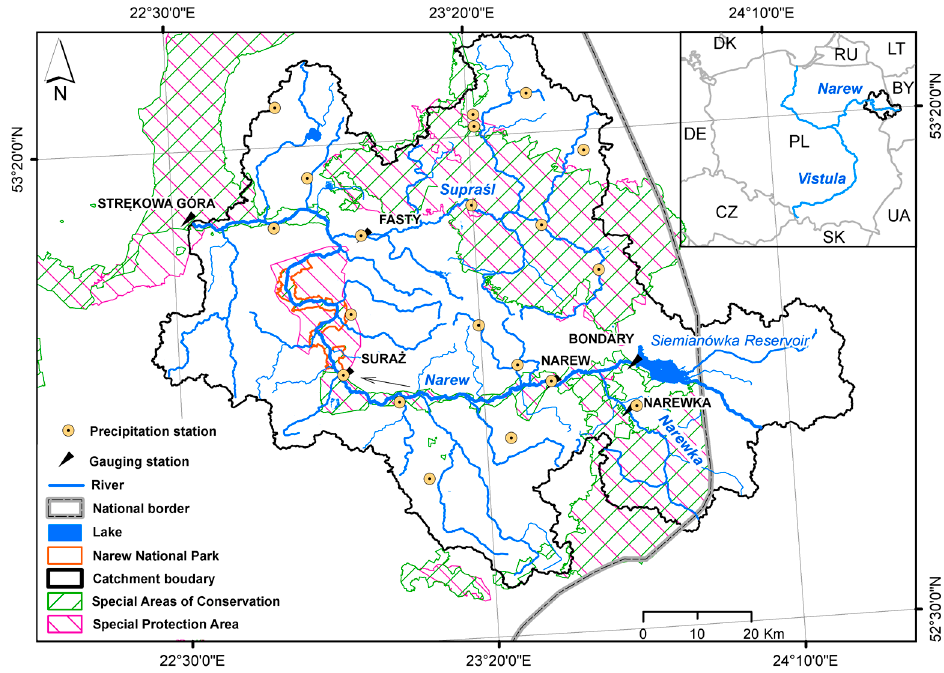
Figure 1. Case study location: Siemianówka Reservoir (SR) and Upper Narew River Catchment, and location of water gauges used to record the data used for the analysis.